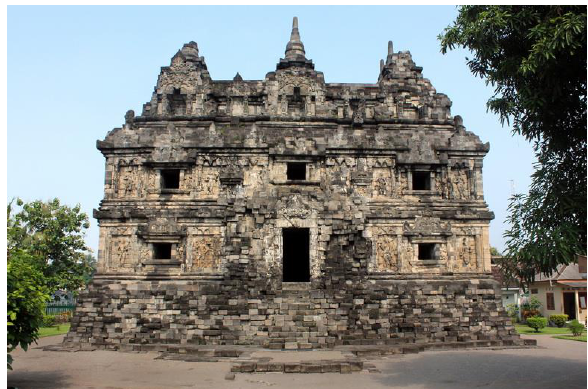
Figure 3. Sample drone photograph of the office